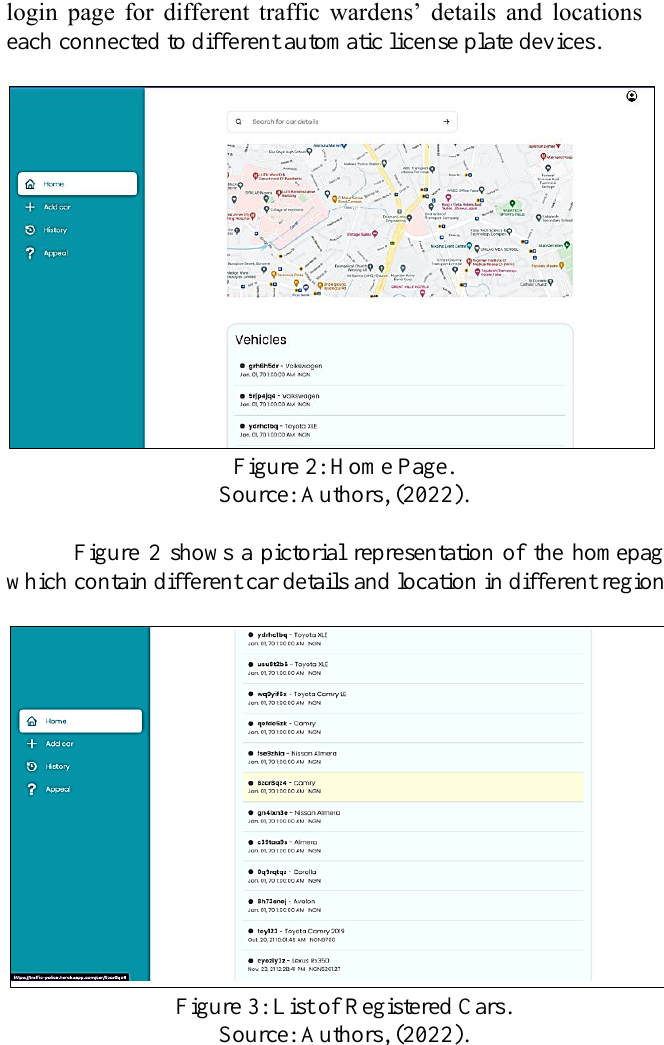
Figure 1: Login Page for Traffic Warden.